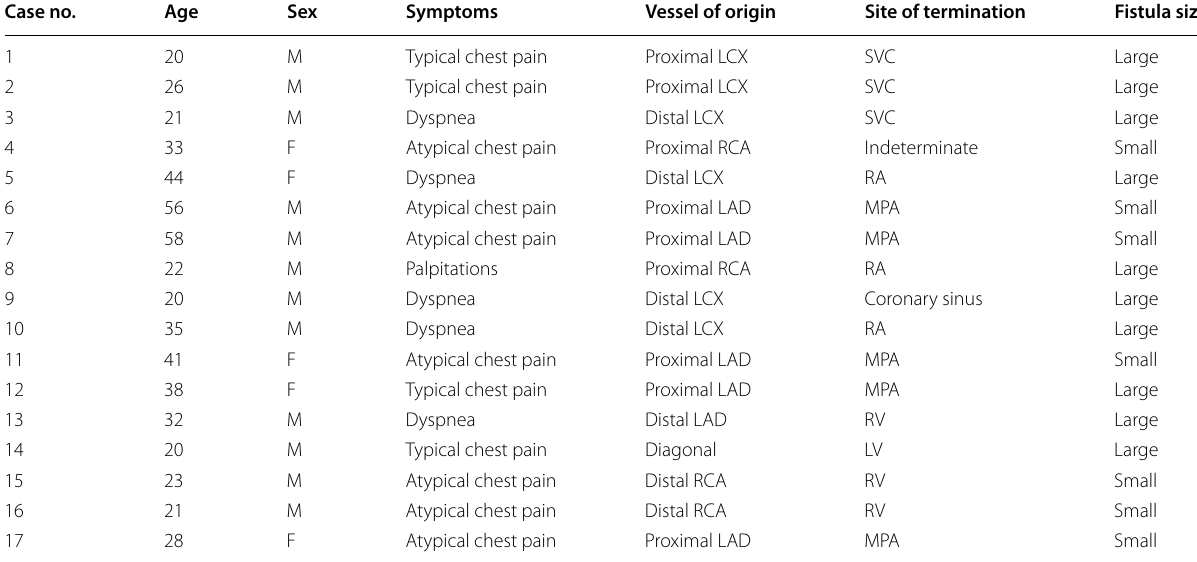
RV right ventricle, LV left ventricle, SVC superior vena cava, LCx left circumflex, LAD left anterior descending, MPA main pulmonary artery, RCA right coronary artery